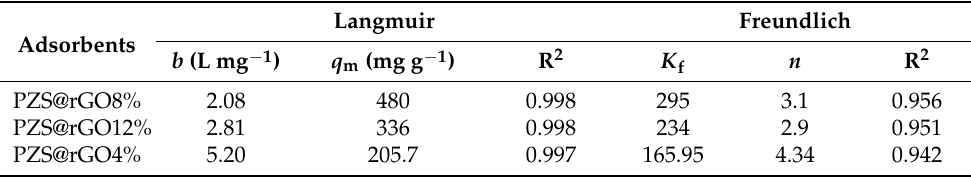
Figure 8. The adsorption isotherm using PZS@rGO x (x = 4%, 8% and 12%) adsorbents at 30 ◦ C: Langmuir ( a ) and Freundlich model plots ( b ). Table 2. Adsorption parameters for Langmuir and Freundlich isotherms.